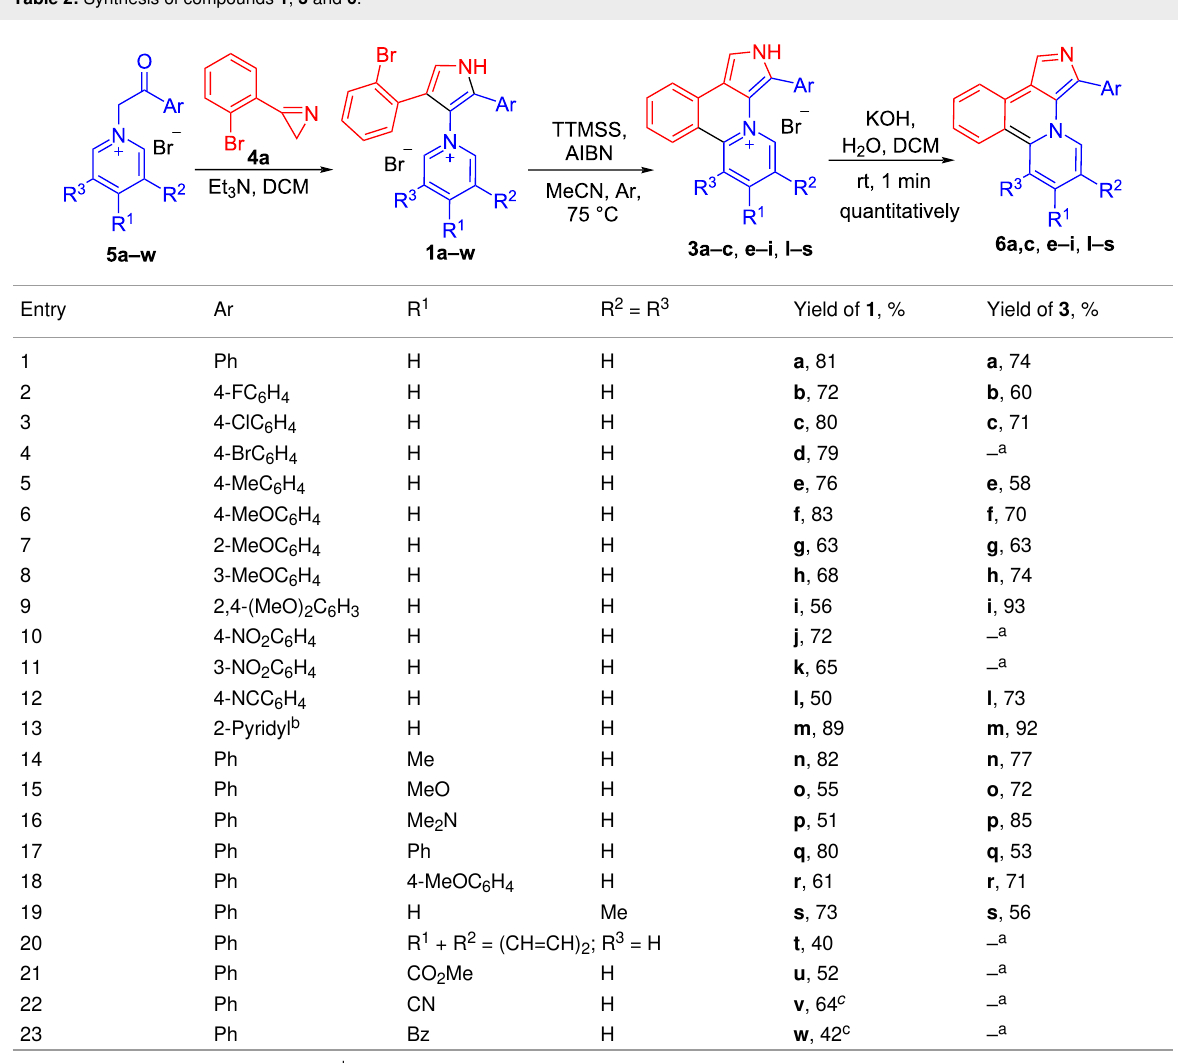
Table 2: Synthesis of compounds 1 , 3 and 6